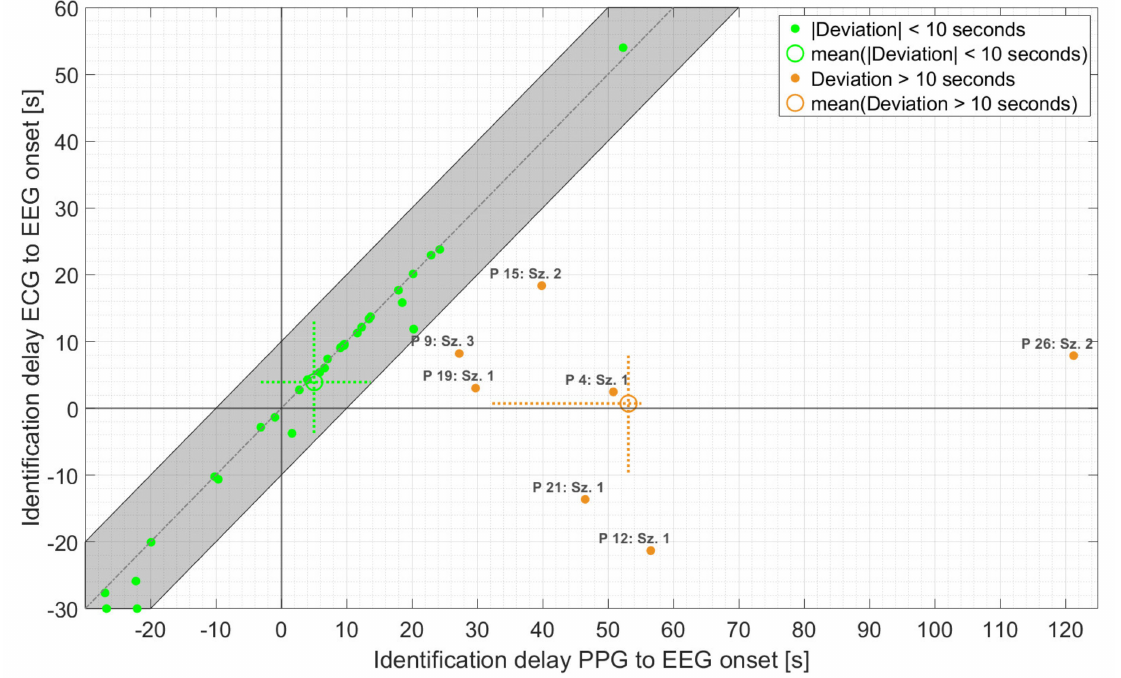
Figure 6. Time of identification of ECG- vs. PPG-based threshold crossings relative to EEG onset, for those seizures for which IT was found by at least one threshold crossing. The identification time refers to the earlier of the two (i.e., either HR > 20% baseline HR or HR > 100 bpm). The dashed crosses at the mean points indicate the 25th to 75th